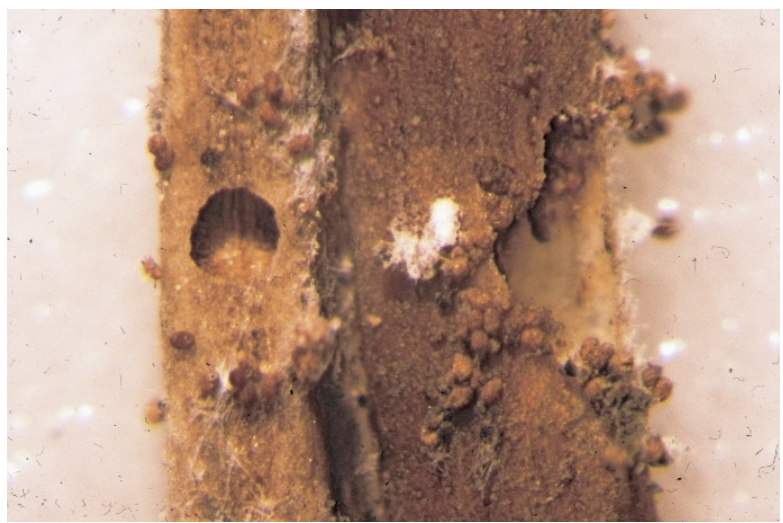
Figure 16. Adults of the mite Steganacarus cf. striculus have bored into these two needles and left many faecal pellets.